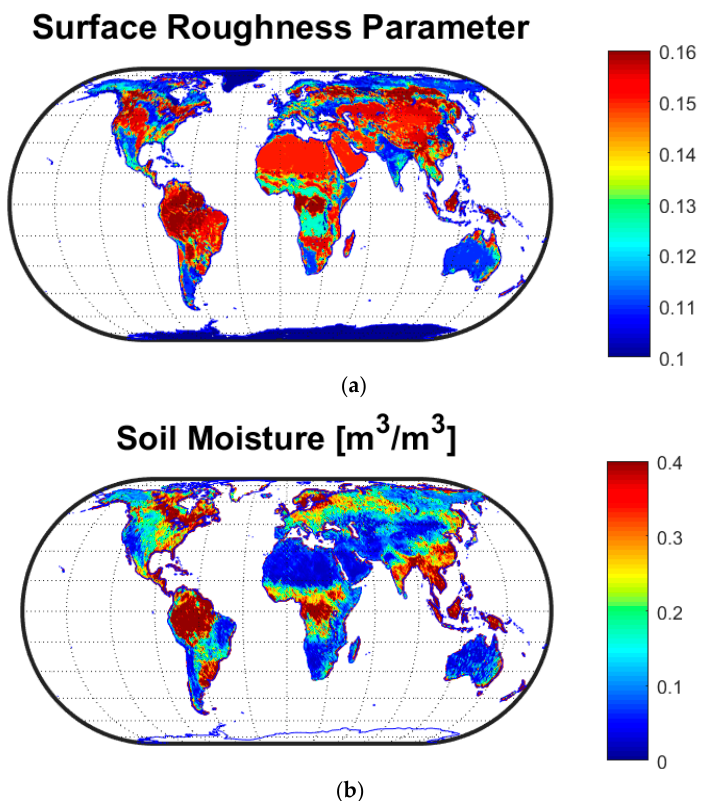
Figure 4. ( a ) Effective surface roughness parameter h over the Earth. ( b ) One-month (from 20 September to 20 October 2017) averaged SMAP-radiometer derived Soil Moisture Content (SMC).